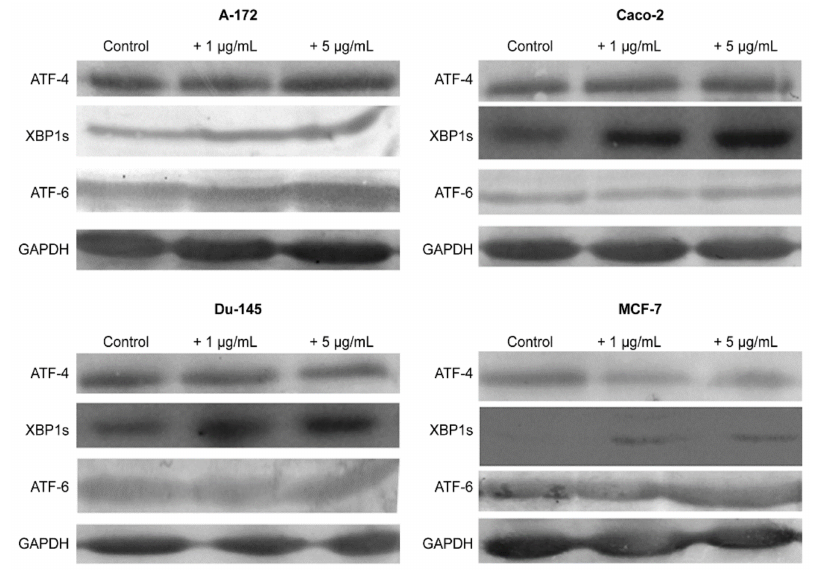
Figure 6. Western blot analysis of ER stress response key markers in various cancer cells after 1 and 5 µ g/mL SeNP treatment for 24